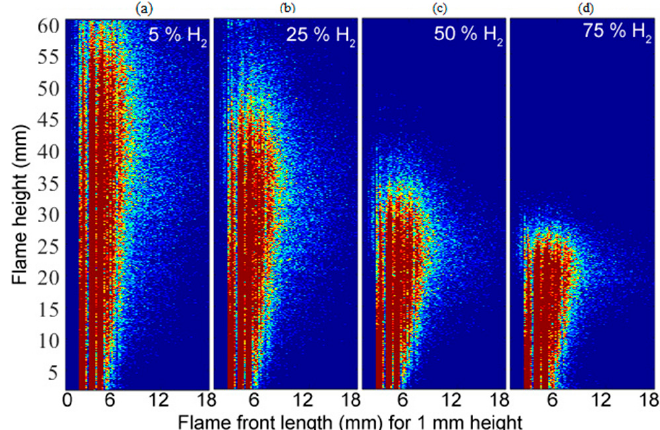
Figure 11. Wrinkled rate under different flame heights with nitrogen dilution volumetric proportion of 10%, Re = 10,690, different hydrogen proportion in fuel: ( a ) hydrogen volumetric rate of 5%; ( b ) 25%; ( c ) 50%; ( d ) 75%.